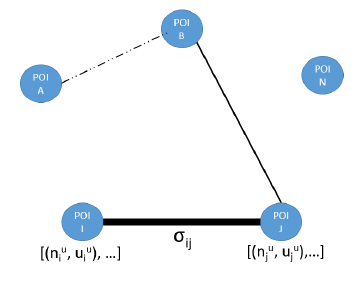
Figure 13. Social